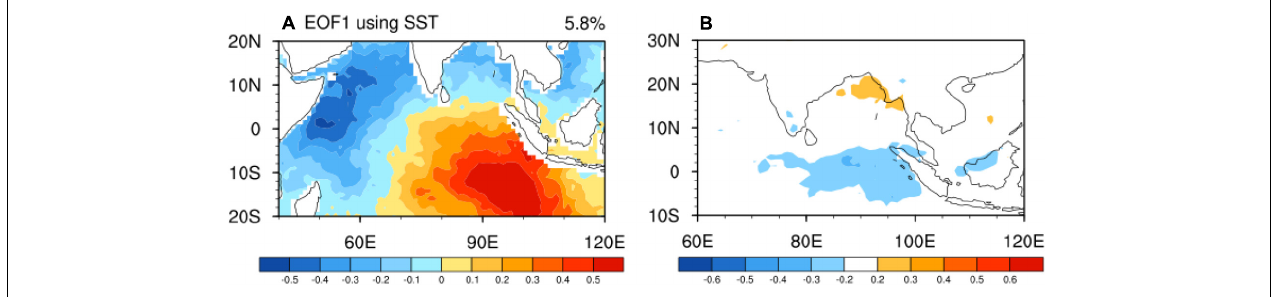
FIGURE 8 | (A) The spatial structure of the first EOF mode using SST ( ◦ C) calculated with ERA5 reanalysis during the period of 1998–2014. (B) Correlation coefficients between intraseasonal precipitation anomalies and the PC1 during boreal summer